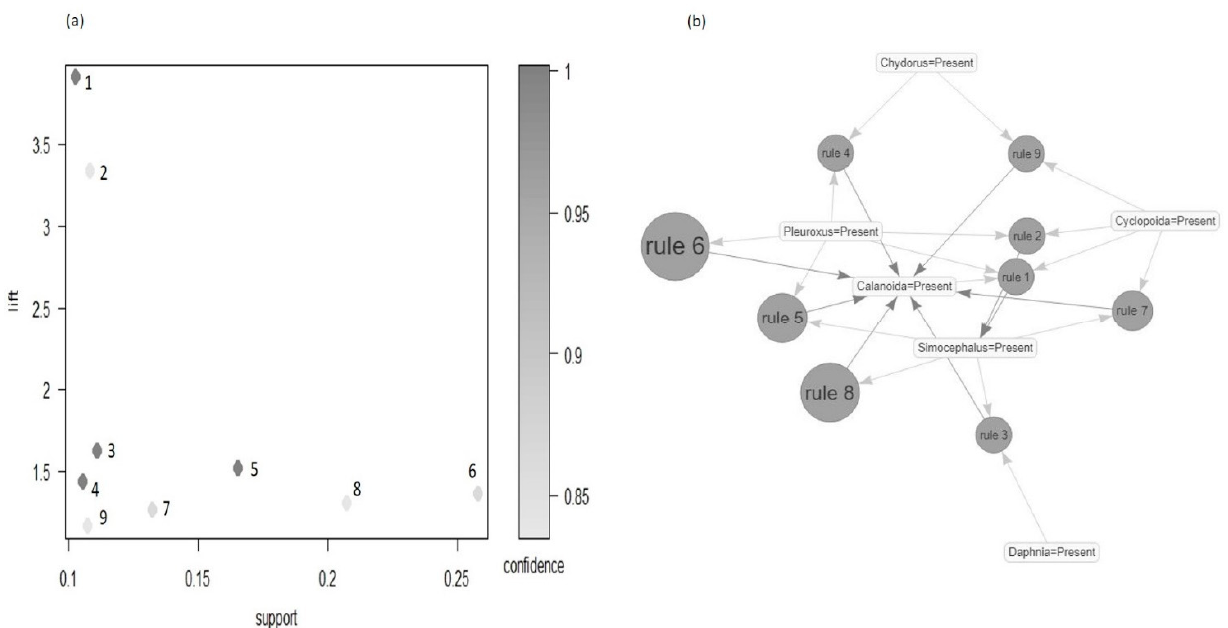
Figure 6. The panel ( a ) shows the scatterplot of the interestingness measure support and lift for each association rule after the pruning procedure. The gray scale color is proportional to the confidence value of each rule. The labels’ number refers to the descending order by lift. The panel ( b ) reports the taxa co ‐ occurrence as network structure. Each taxon is related to the others by the association rule estimated with FP ‐ growth algorithm. The labels’ number of each rule is related to the descending order by lift.